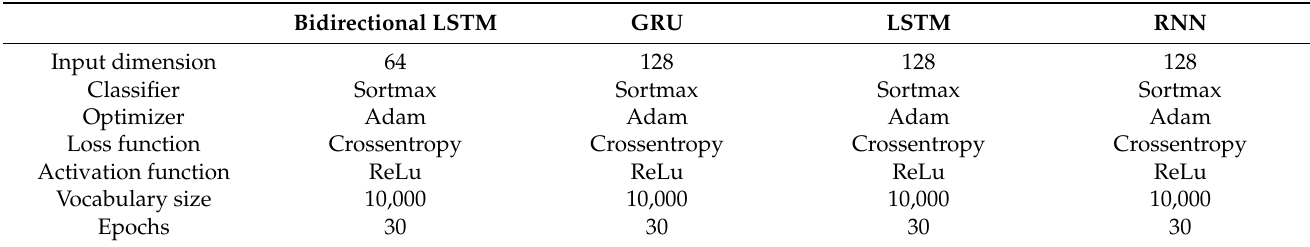
Table 3. Hyperparameters used to examine the models based on